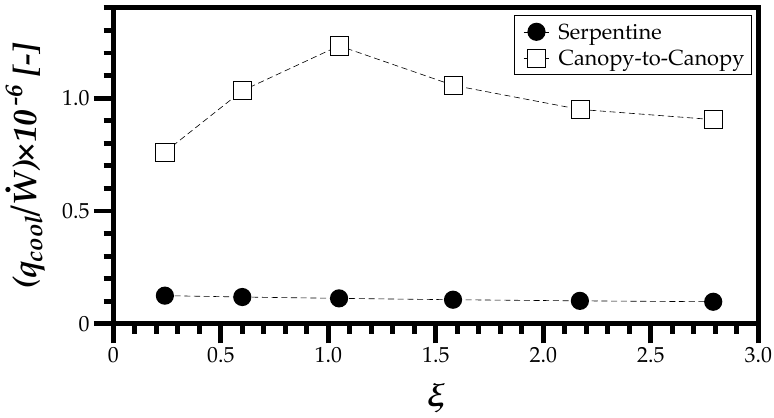
Figure 7. Cooling-capacity-to-pumping-power ratio as a function of the aspect ratio. Data retrieved from